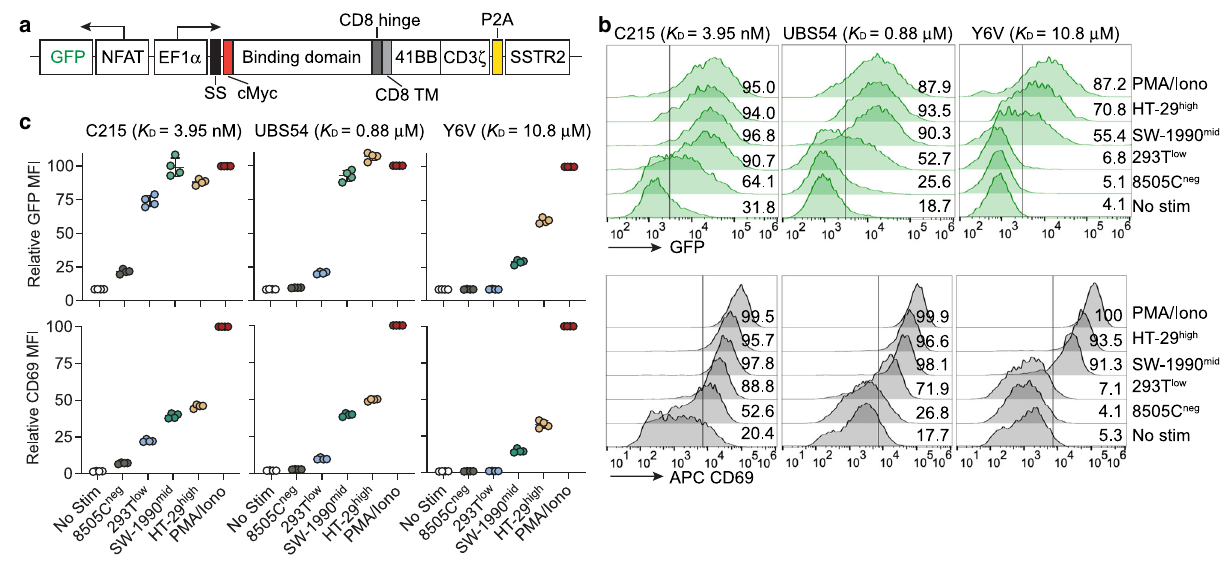
Fig. 5 | CAR af fi nity and tumor antigen density regulate the degree of NFAT activation. a Lentiviral vectors encoding C215-iGFP, UBS54-iGFP and Y6V-iGFP CARs. b Flow cytometric quanti fi cation of CAR-mediated NFAT activation, as indicated by NFAT-driven GFP expression in Jurkat CAR-T cells following stimula- tion for 24h with target cells. CD69 was used as a marker for T-cell activation.